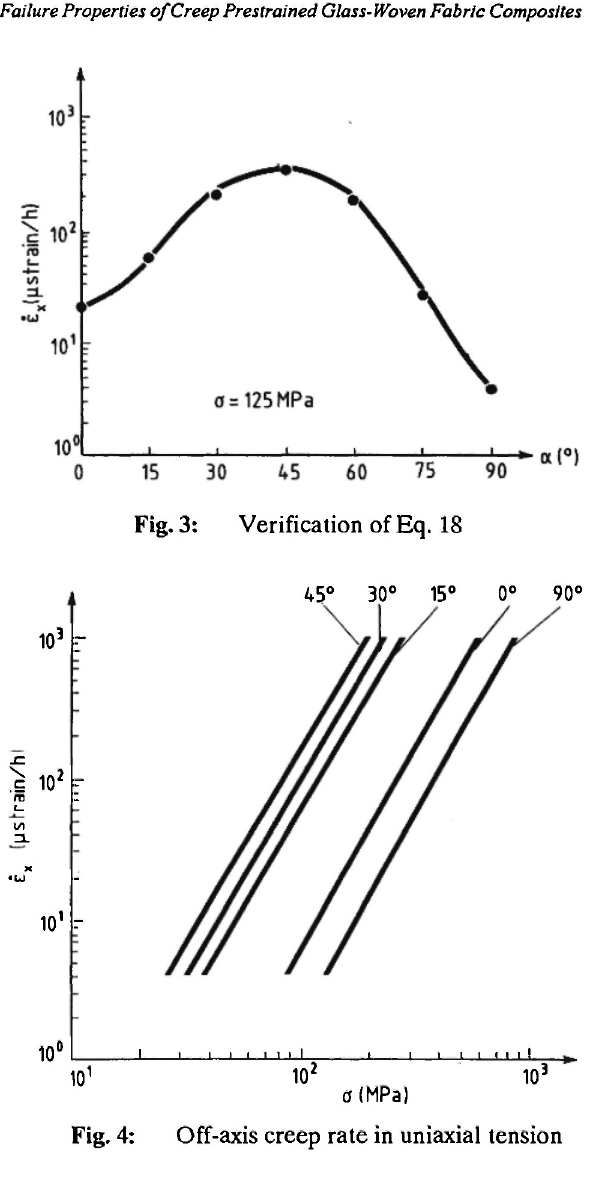
to the theoretical prediction of Eq. 10. The strength parameters, a^ and i^, were evaluated from tests at 0° and